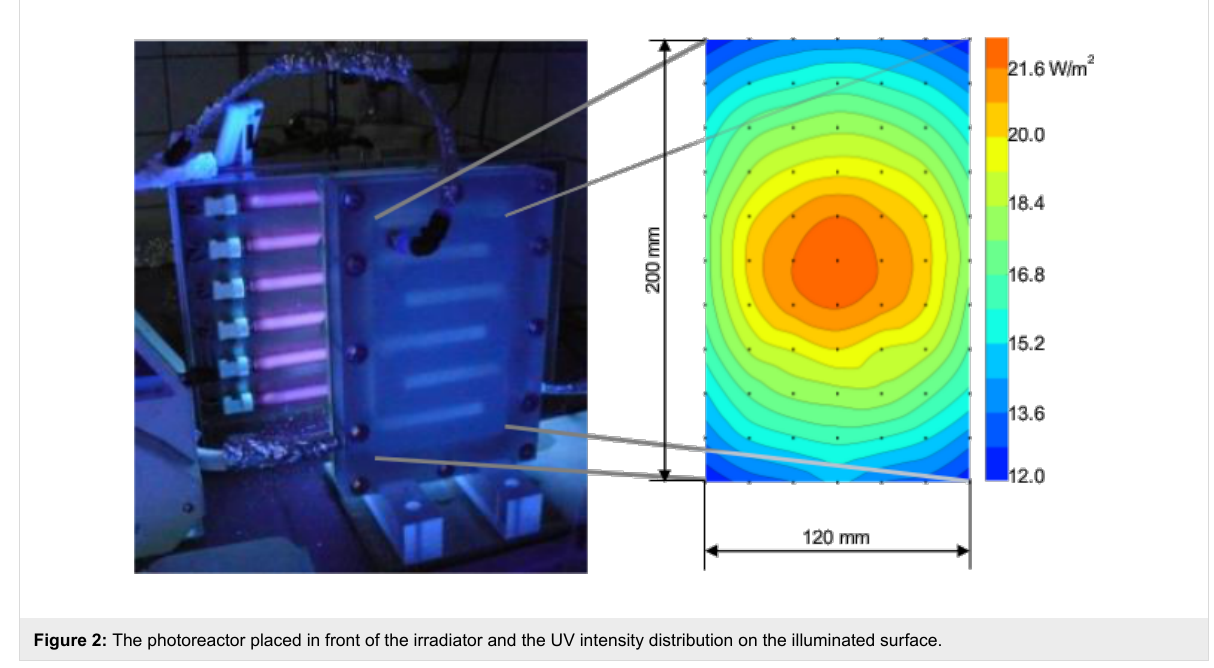
Figure 2: The photoreactor placed in front of the irradiator and the UV intensity distribution on the illuminated surface.